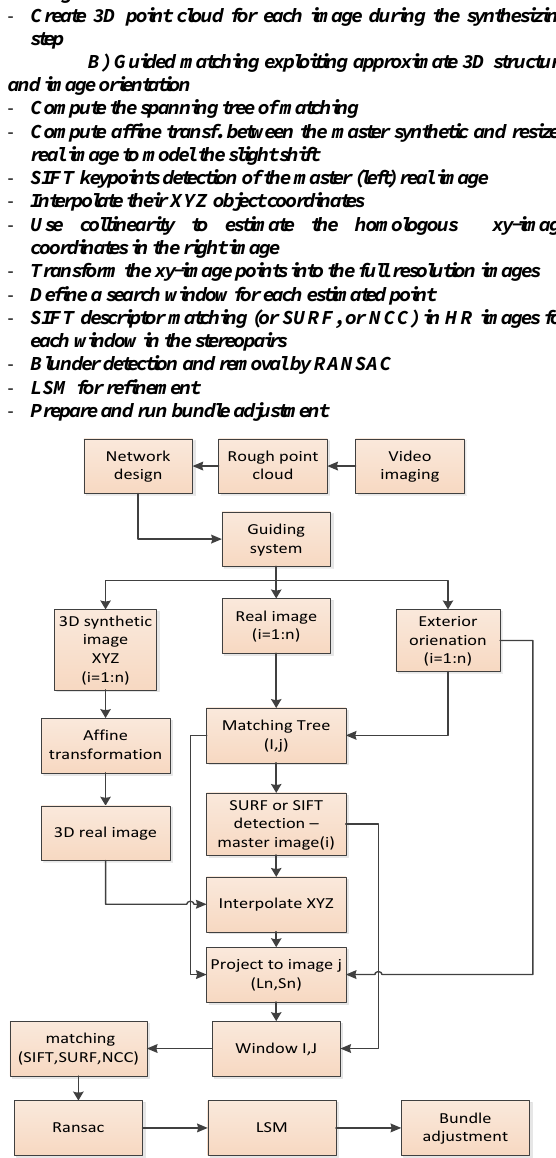
Figure 5. The guided - Matching methodology by exploiting the 3D model